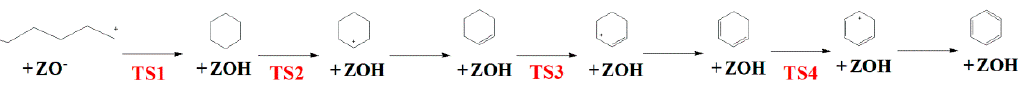
Scheme 2. Reaction network for the formation of benzene in the transition period for propane aromatization over H-ZSM-5 catalysts. ZOH and ZO − represent the protonated and deprotonated acid sites of zeolite, Table 6. Calculated free energy barriers ( Δ G int ≠ ), rate constants ( k ), enthalpy barriers ( Δ H int ≠ ), and entropy losses ( − T Δ S int ≠ ), as well as reaction free energies ( Δ G R ) at 823 K for each reaction step in the formation of benzene in the transition period for propane aromatization over H-ZSM-5.